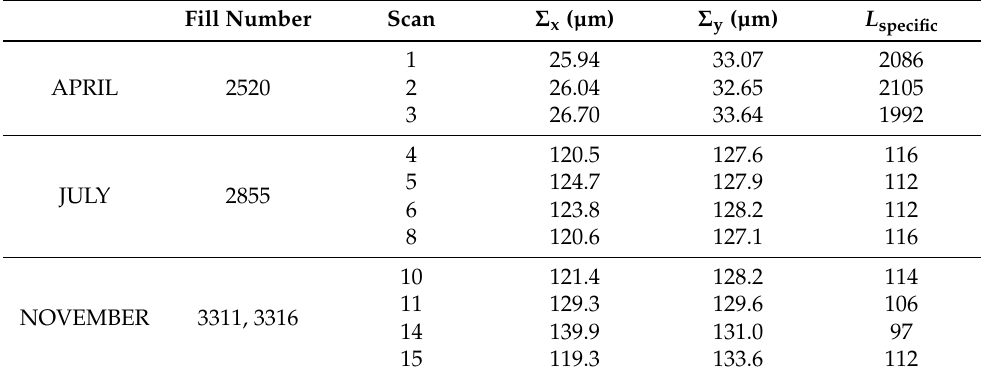
Table 6. MPX01 vdM scan results for 2012 data. The fit results for the bunch-averaged horizontal, Σ x , and vertical, Σ y , convoluted beam sizes are given. The units of the specific luminosity, L specific , are